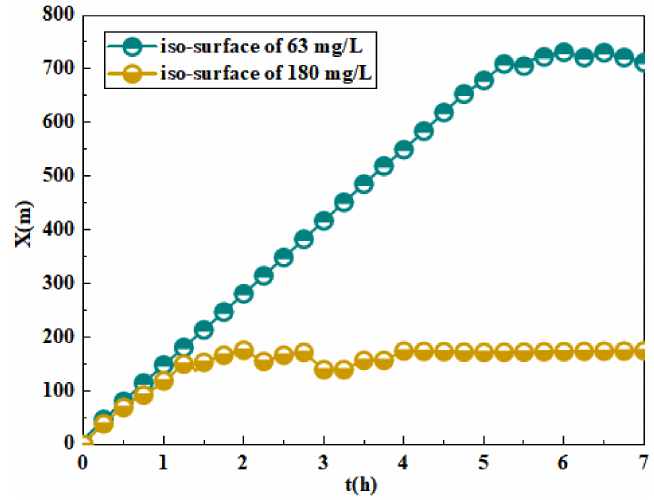
Figure 11. Change of the position of the iso-surface of different concentration along x -axis at M s = 1.38